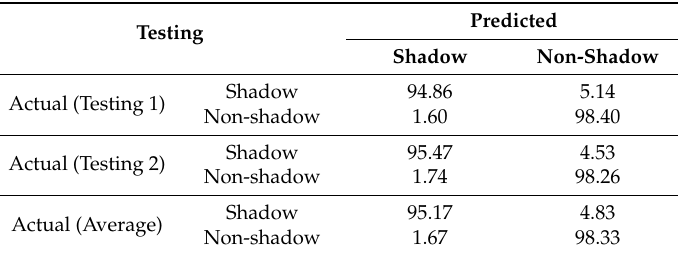
Table 5. The confusion matrix of testing results (unit: